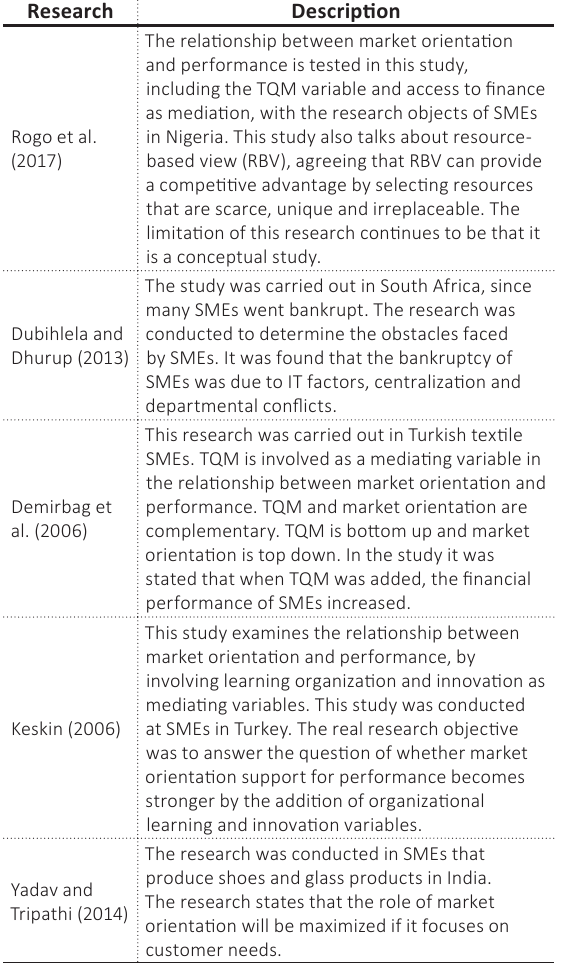
Table 1 provides a brief explanation of each study. Table 1. Brief explanation of previous